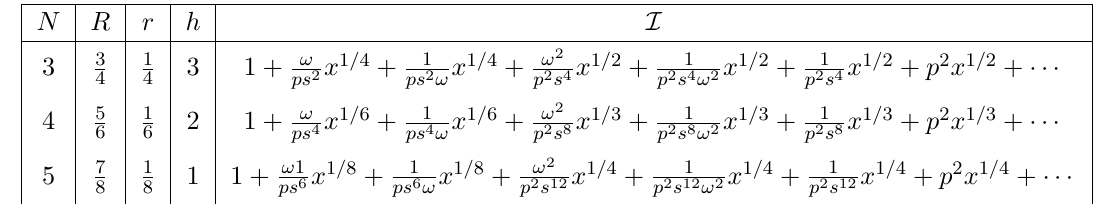
(cid:0) (cid:1) x h .